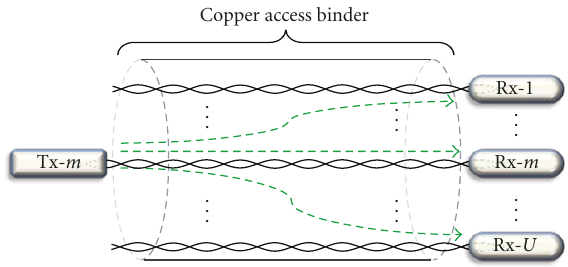
Figure 1: NEXT and FEXT interferences in a copper cable binder for a DSL network with U number of near-end transmitters (Tx) and far-end receivers (Rx).